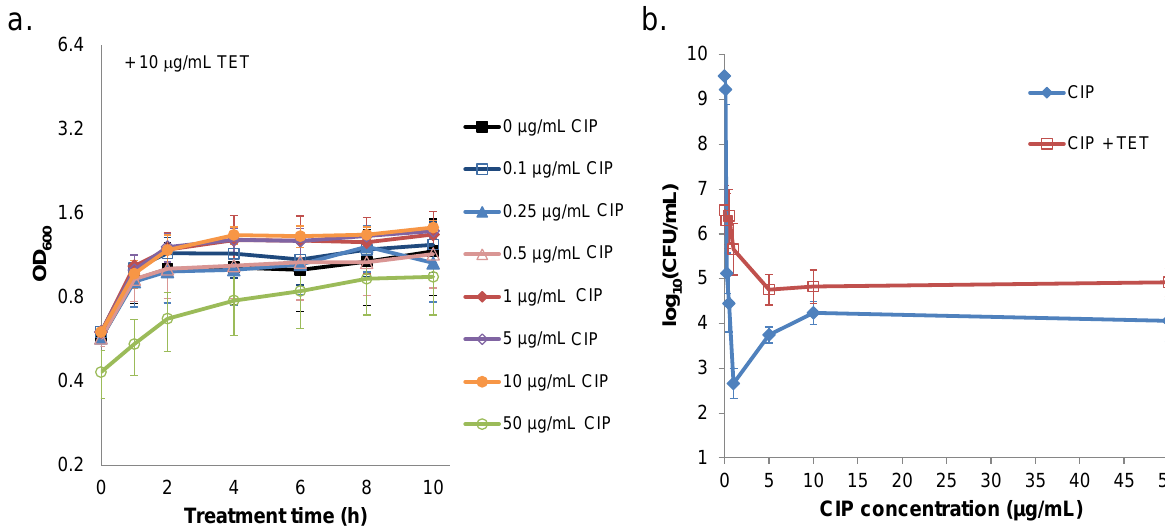
Figure 3. Ciprofloxacin (CIP) treatment of S. aureus in the presence of tetracycline. S. aureus NCTC 8325 was grown in LB for 4 h and then treated with 10  g/mL tetracycline (TET), which immediately preceded the addition of 0–50 µg/mL CIP. ( a ) At designated time points, samples were collected for OD 600 measurements. Data points represent the mean and error bars the SEM of three replicates, except for 50 µg/mL, which was replicated twice. ( b ) After 10 h of treatment with CIP and TET, samples were washed to remove the antibiotics, serially diluted, plated on LB agar, and incubated overnight to enumerate CFUs. For reference, experiments performed without the addition of TET (blue) are depicted in panel ( b ). Data points are the mean of the log 10 (CFU/mL) across three replicates, and error bars indicate SEM. Results from experiments with TET added after 1 h of CIP treatment are provided in Figure